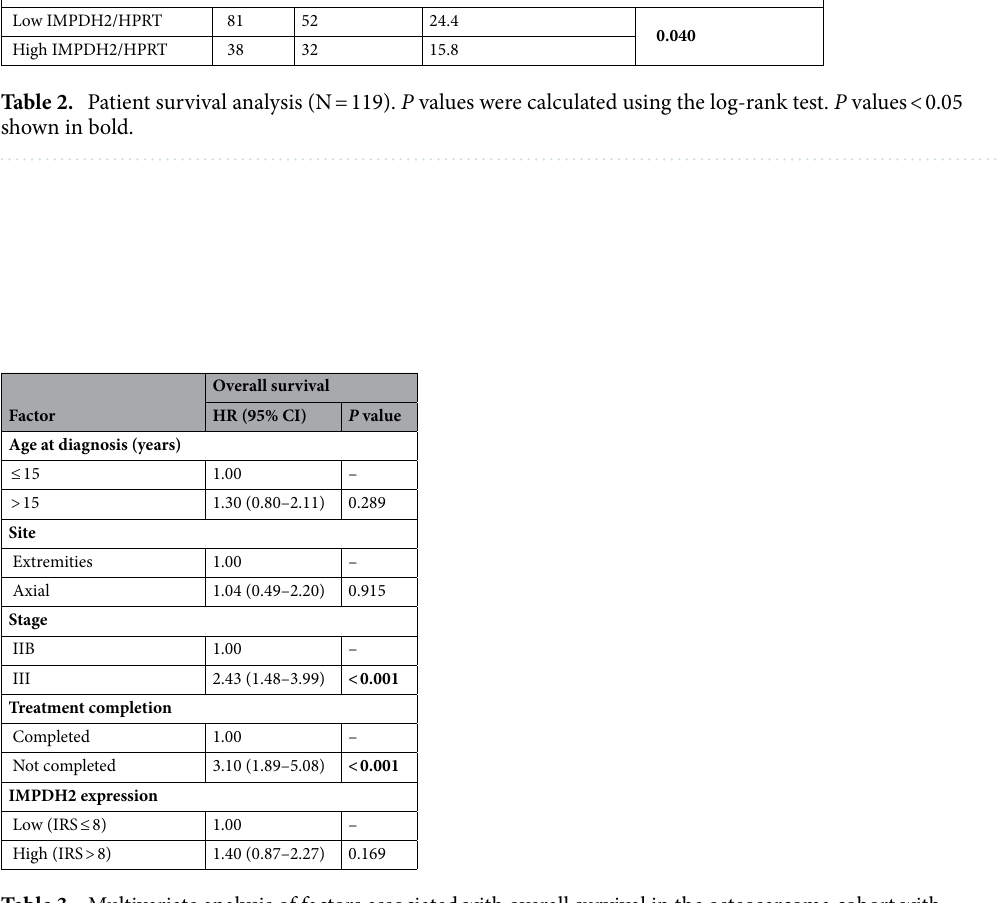
Table 3. Multivariate analysis of factors associated with overall survival in the osteosarcoma cohort with inclusion of IMPDH2 expression.